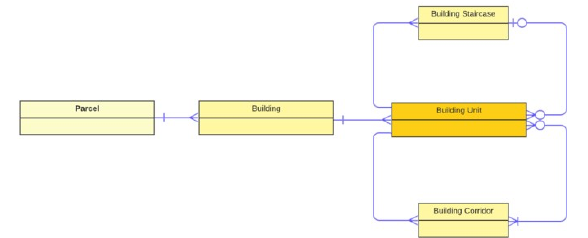
Figure 13. Relationship between parcel, building and units.